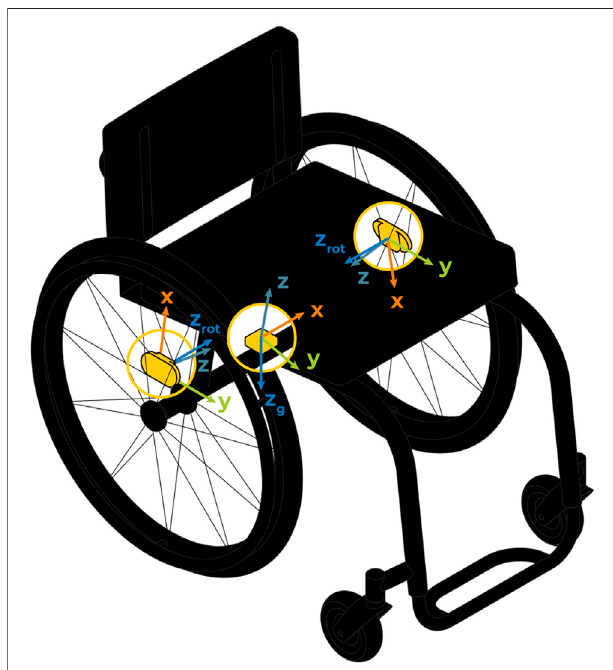
FIGURE 1 | A set of three ZurichMOVE Sensors was mounted on participants ’ wheelchairs, one on the main frame, and one on each wheel to allow the assessment of motion and